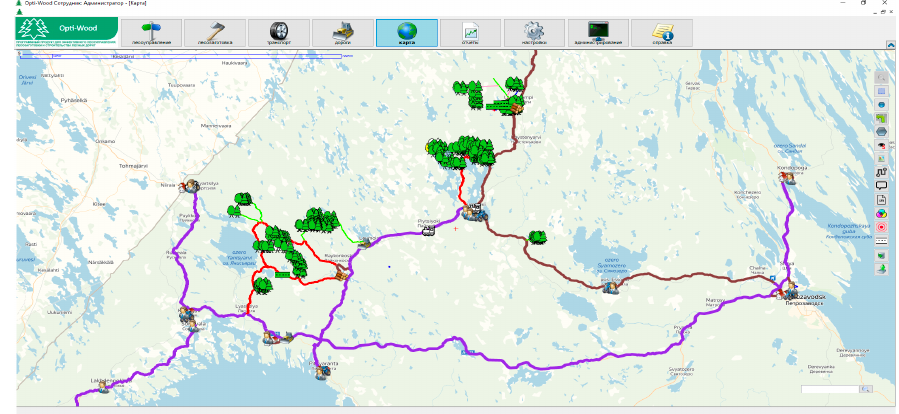
Forests 2020 , 11 , 662